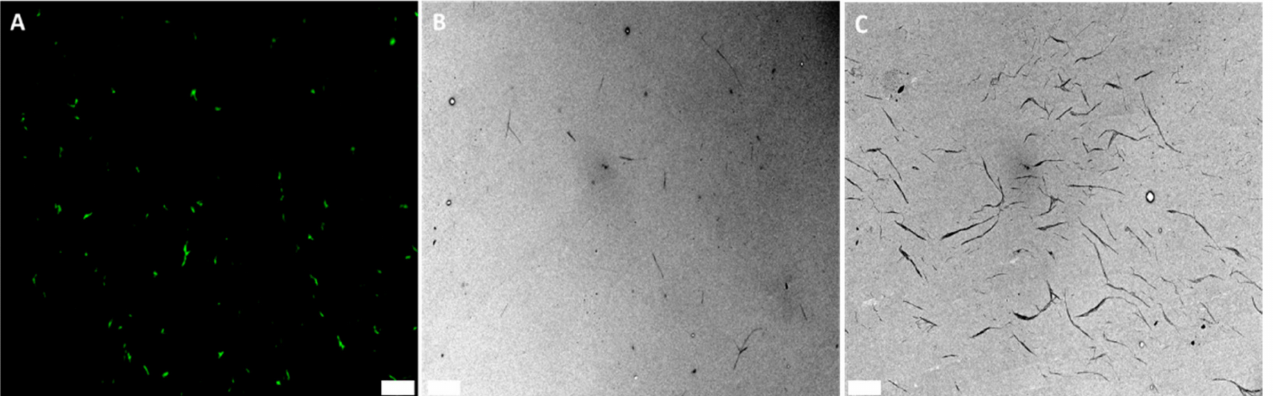
Figure 5. Microscopic images of GFP–CBM:BCNC (0.002 mg/mL) mixed with 2% gelatin (1:1) ( A , B ) and of GFP–CBM:BCNC aqueous suspension ( C ). ( A ) FM image. ( B , C ) TEM images. Scale bars: ( A ) 20 µ m and ( B , C ) 1 µ